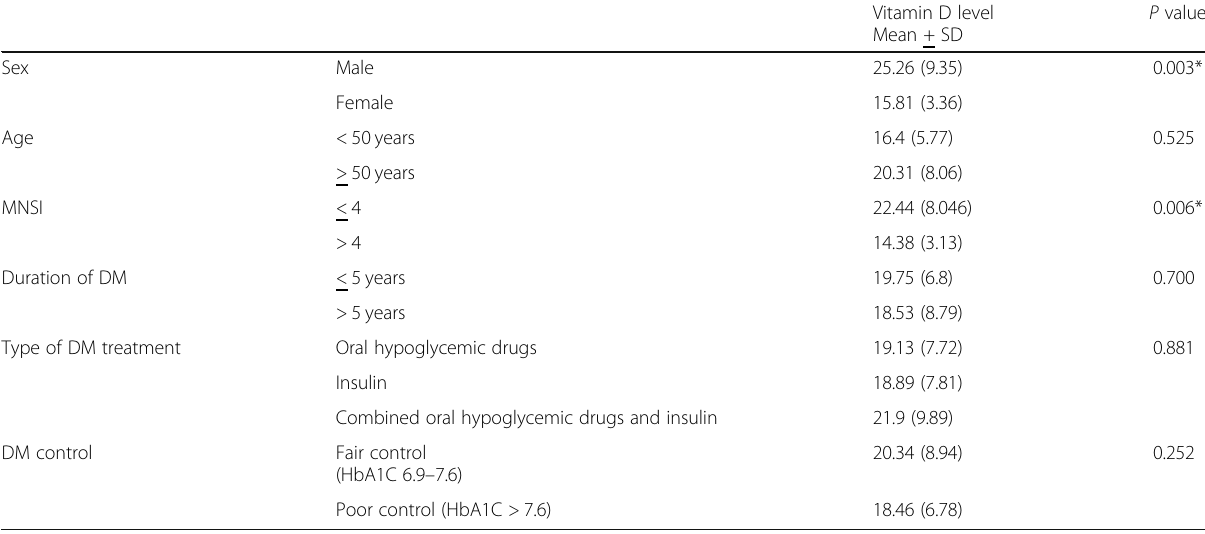
Table 5 Comparison between vitamin D levels in different demographic and clinical situations in diabetic peripheral neuropathy